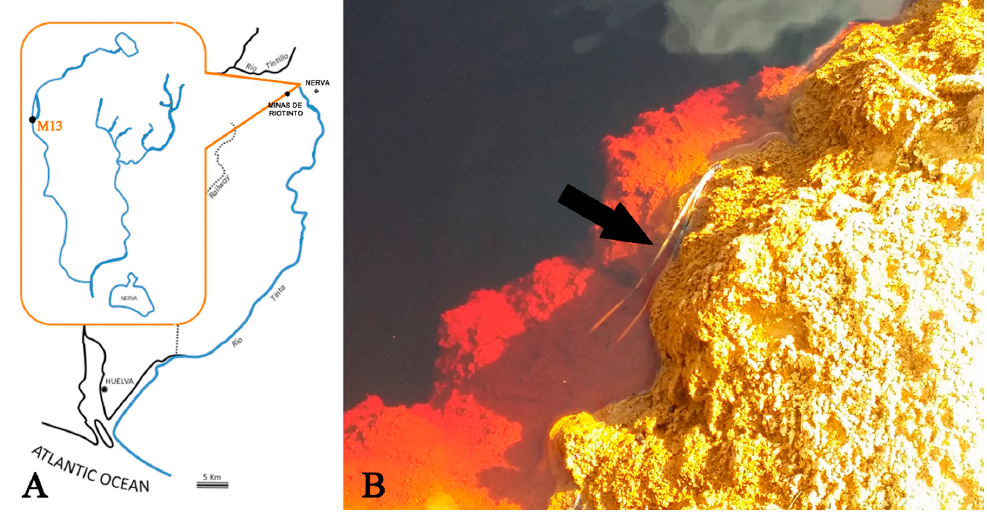
Figure 1. ( A ) Location of the study area, showing the M13 sampling site. Scale corresponds to 5 km; ( B ) Field photography of the mineral deposits sampled in this study. The arrow shows a pine needle as scale.